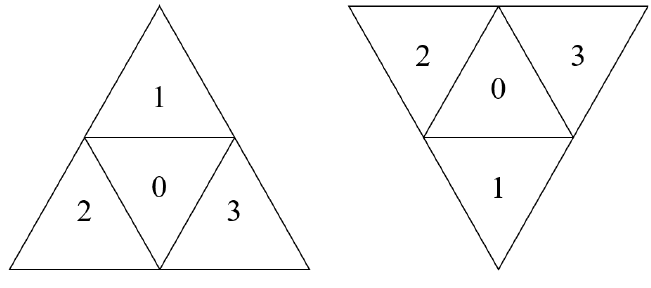
Figure 2. Goodchild encoding method.